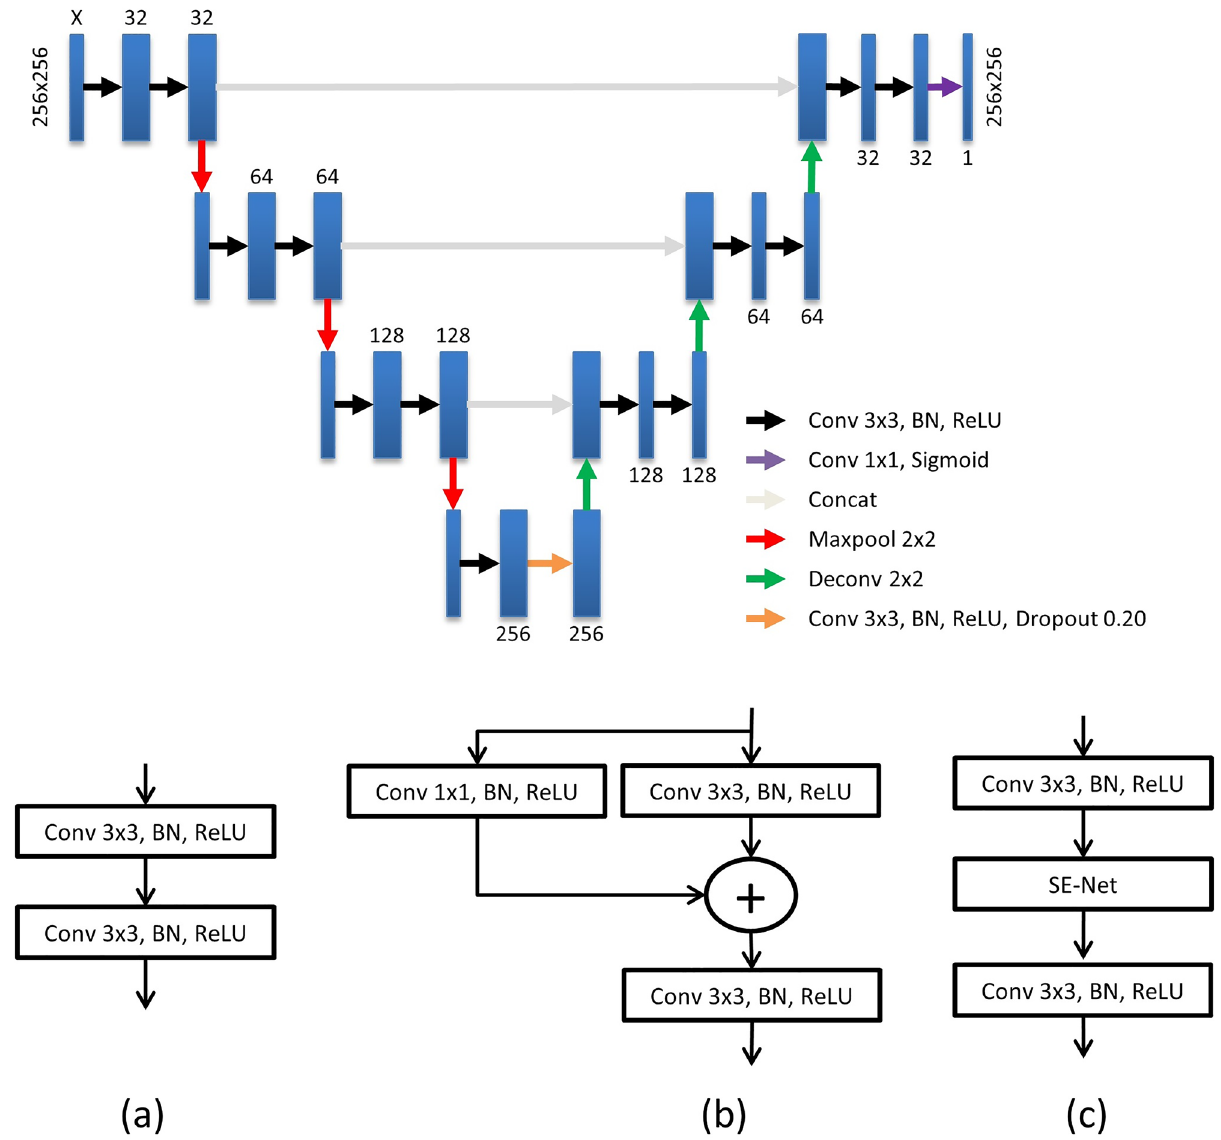
Figure 3. 2D segmentation architectures. (a) U-Net, (b) residual U-Net, (c) SEU-Net with constant ratios X = {1,2,3} in stages {1,2,3} respectively. See Fig. 2 for